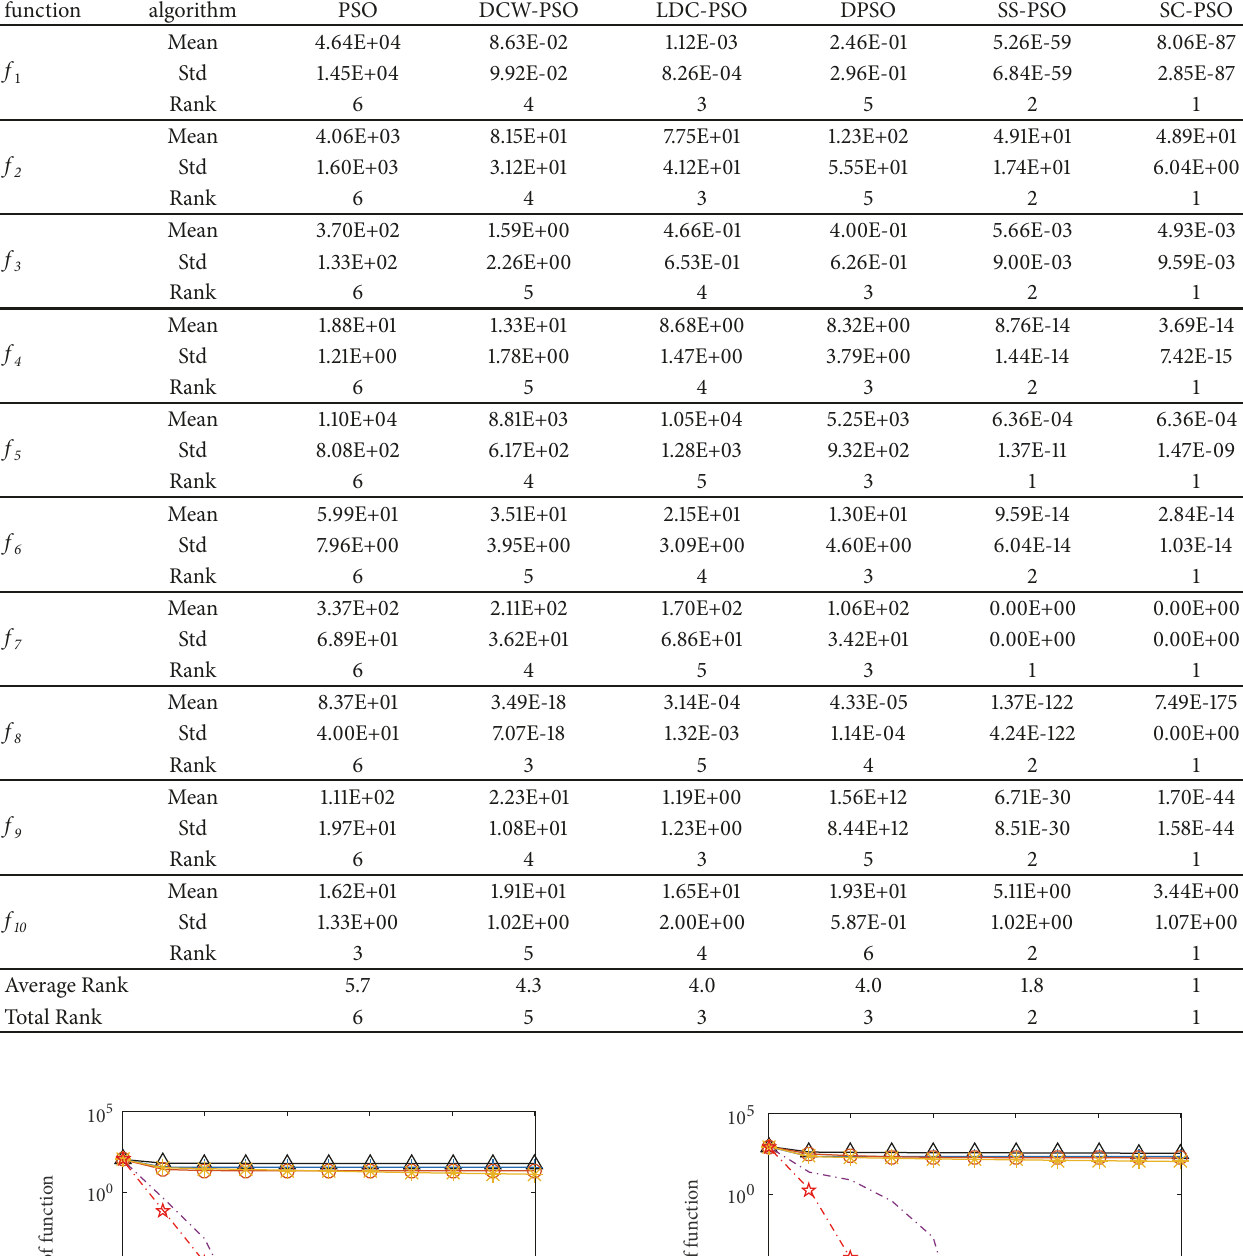
Table 3: Comparison of the optimization results on benchmark functions (50D).